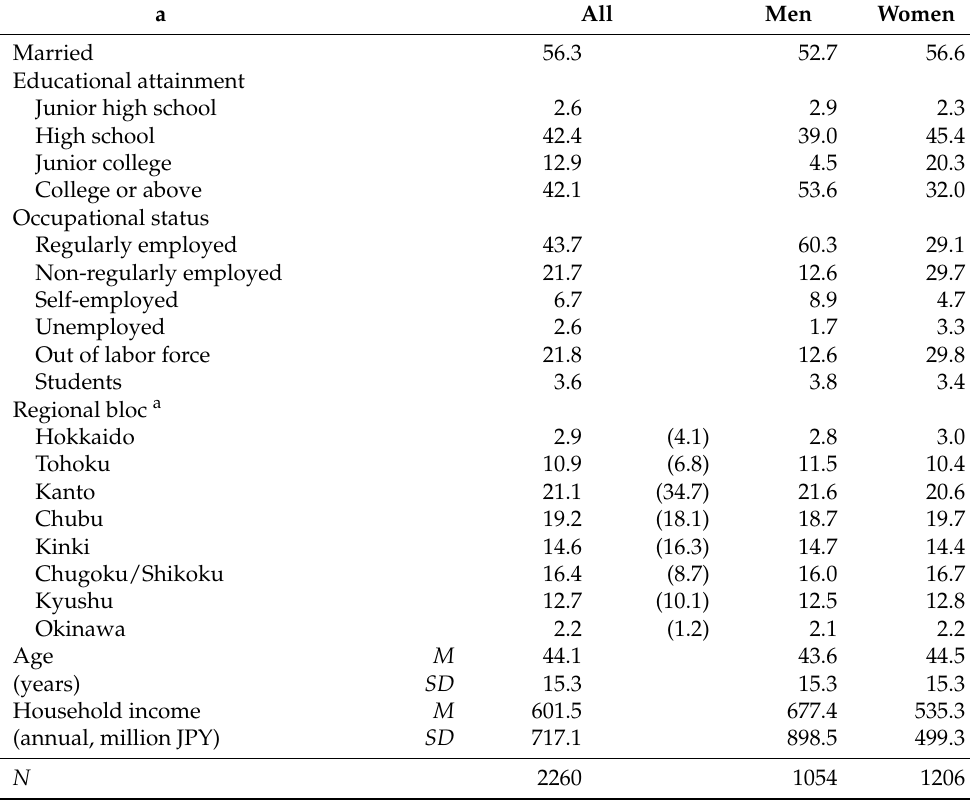
a Numbers in parentheses indicate the actual proportions of population in